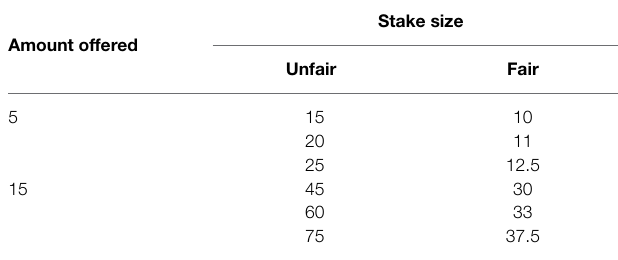
TABLE 1 | Ultimatum Game